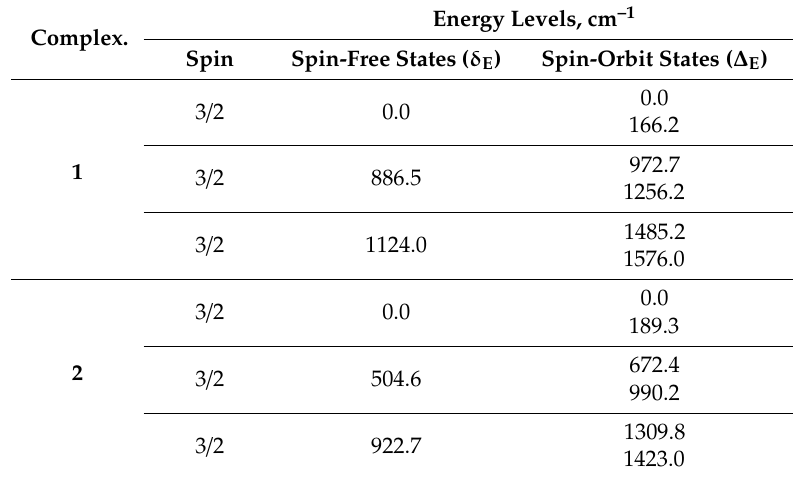
Table 3. Calculated spin-free state ( δ E ) and spin-orbit state ( ∆ E ) energies (cm − 1 ) for 1 and 2 . Energy Levels, cm –1 Complex. Spin-Free States ( δ E )